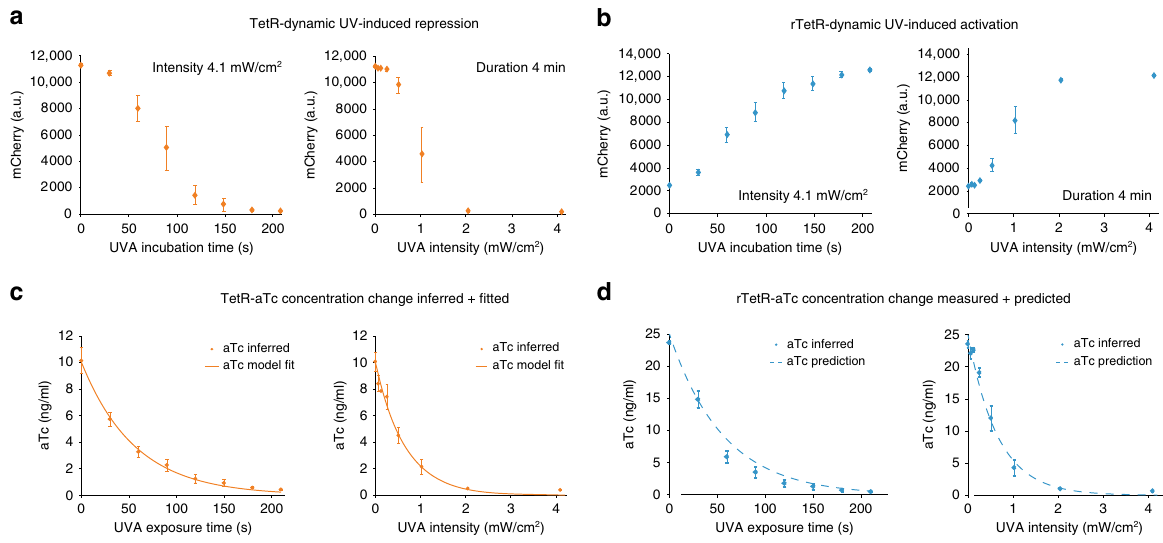
Fig. 2 UVA mediated aTc inactivation. aTc inactivation was studied using TetR (orange diamonds and lines, a , c ) and rTetR (blue diamonds and dashed lines, b , d )-controlled promoters as biosensors. aTc inactivation is controllable with duration ( a , b left, intensity 4.1 mW/cm 2 ) and intensity ( a , b right, duration 4 min) of the UVA light input. a Left, using 10 ng/ml aTc and a TetR containing strain, we applied UVA light with an intensity of 4.1 mW/cm 2 with increasing duration (0, 30, 60, 90, 120, 150, 180, and 210 s) to different samples to follow aTc degradation over time. a Right, using again a TetR containing strain and 10 ng/ml aTc, we applied increasing UVA light intensities (0.064, 0.13, 0.26, 0.51, 1.0, 2.1, and 4.1 mW/cm 2 ) at a fi xed duration of 4 min to follow light-intensity-dependent aTc degradation. b Left, analogous to the experiment shown in a , left, we also performed duration-dependent aTc degradation with our rTetR containing strain and 25 ng/ml aTc. b Right, analogous to a , right, we incubated our rTetR containing strain and 25 ng/ml aTc with increasing UVA light intensities. c The inferred aTc concentrations of the duration and intensity degradation experiments shown in a were fi t to an exponential decay model Eq. (2) using the TetR-controlled mCherry expression system as a sensory module. The exponential decay equations are of the form f ( u ) = e − cu , where u represents the input (light intensity or light duration), and c is the decay factor. d Using the same degradation model and parameters obtained from the model fi tting shown in c , aTc degradation is correctly predicted in the rTetR-controlled system. Experiments were performed in nonsaturating aTc concentrations with 10 ng/ml for the TetR and 25 ng/ml for the rTetR containing strain. Diagrams show mean mCherry expression values and standard deviation of three biological replicates ( n = 3) measured after 5 h incubation time in all cases. Source data are provided as a Source data fi